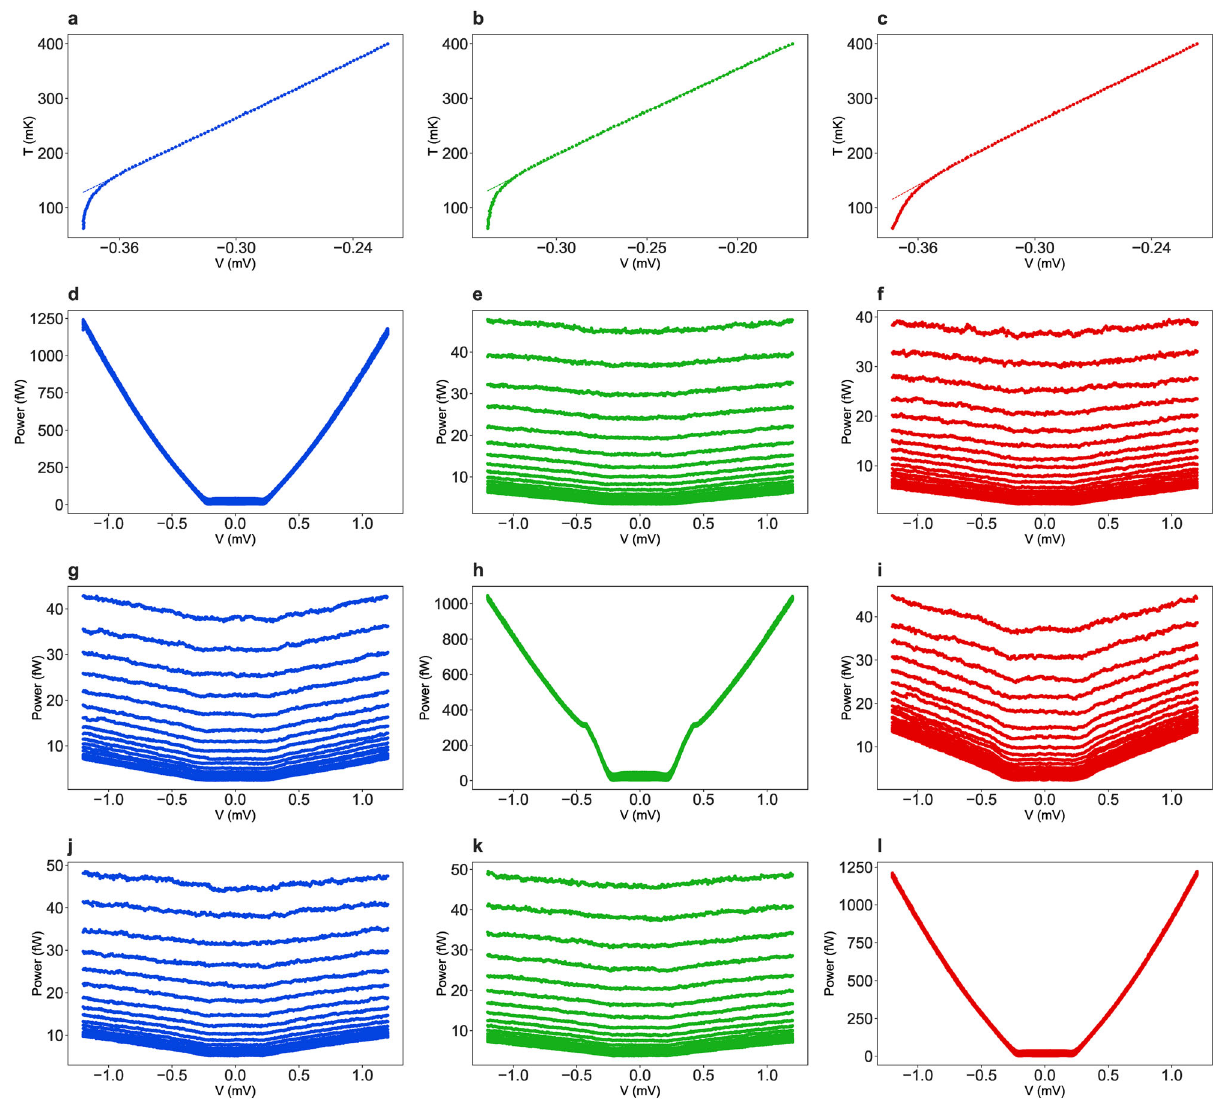
Fig. 7 Experimentally measured electron temperature of the SINIS thermometers. Calibration of the SINIS thermometer connected to the left resistor R L indicated by blue ( a ), to the right resistor R R — green ( b ) and to the hot resistor R h — red ( c ). The dashed lines indicate the polynomial data fi tting. In all these plots the horizontal axis shows the voltage drop across the SINIS structure at fi xed bias current and the vertical axis — the temperature of the mixing chamber. Figures d , h , l show the dependence of the power dissipated in, respectively, left, right and hot resistors versus heating voltage applied to the same resistor. Figures g , j show the non-local response in the system, where the power dissipated in the left resistor is plotted versus the heating voltages applied to the right ( g ) and to the hot ( j ) resistors. We also plot the non-local response of the right resistor on the bias voltages applied to left ( e ) and to the hot (( k ) resistors, and of the hot resistor on the bias applied to left ( f ) and right ( i )